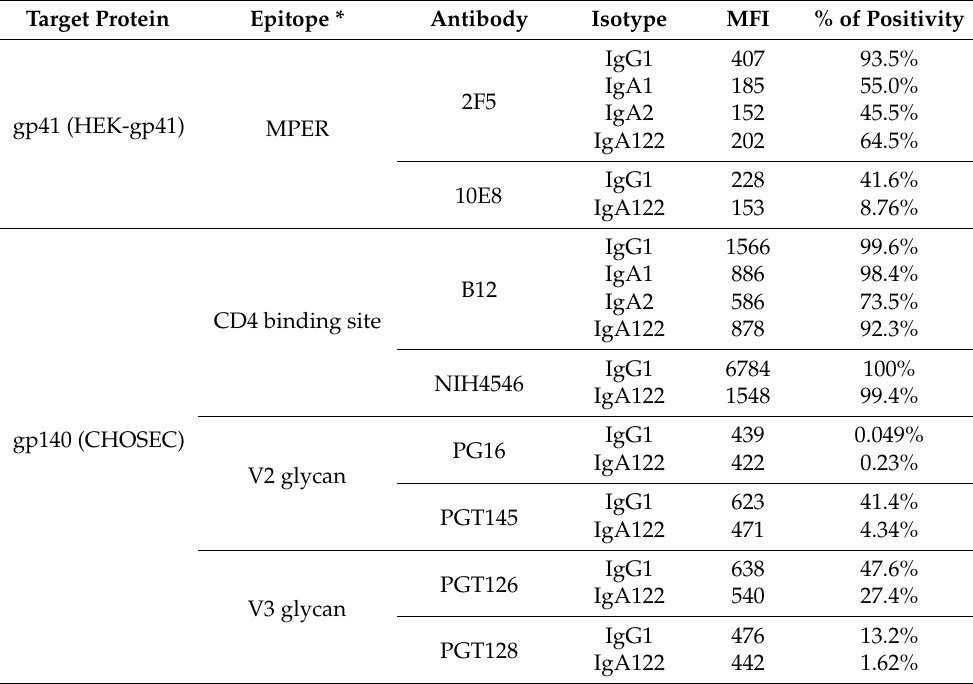
Table 1. Efficacy of binding of the different isotypes on Env-expressing cells by flow cytometry. Percentage of positivity of cells with 5 µg/mL of antibodies (n = 3).